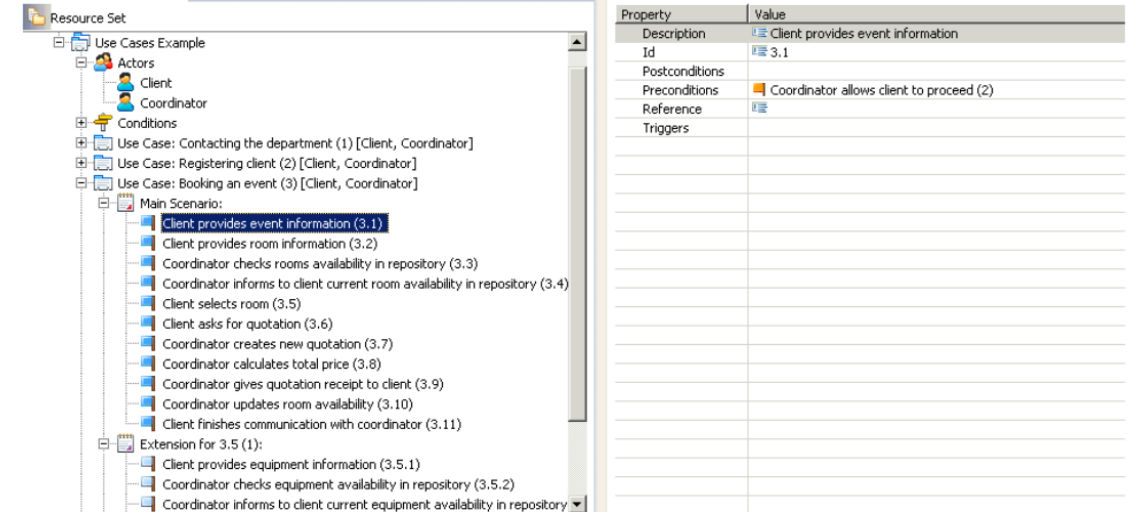
Fig. 2. General view of the Use Case